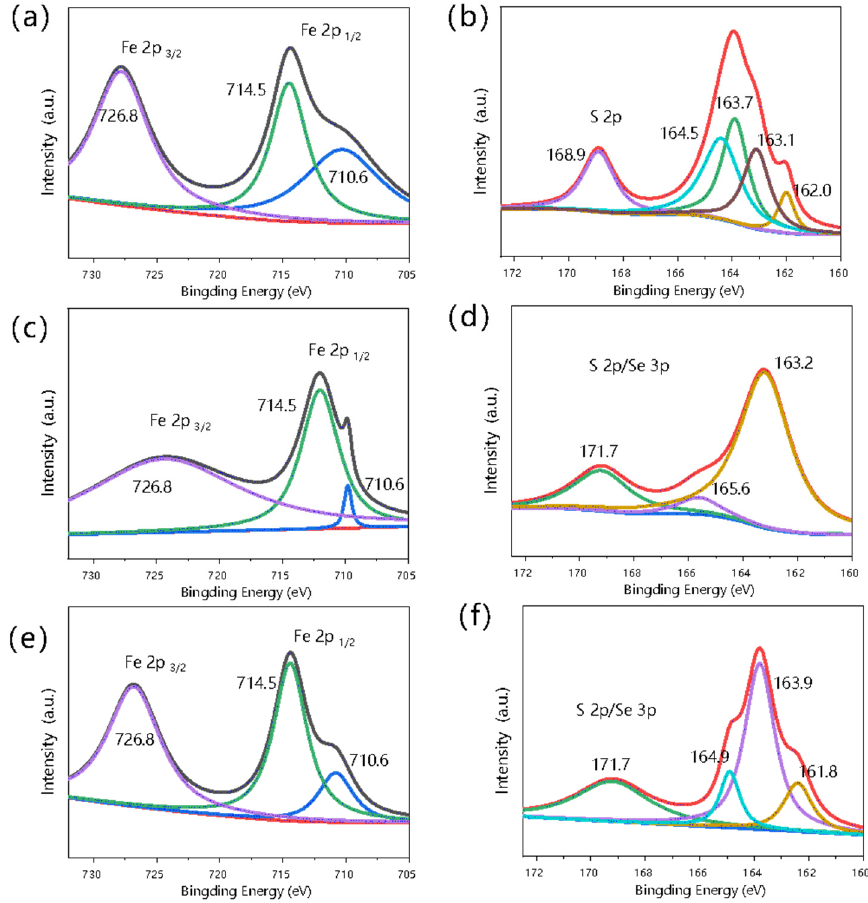
Figure 4. X − ray photoelectron spectra with the deconvolution of XPS peaks of Fe2p and S2p/Se3p of original FeMgAl − MoS 4 ( a , b ), and after FeMgAl − MoS 4 adsorbed 500 ppm Se(IV) ( c , d ), and 500 ppm of Se(VI) ( e , f ), respectively.